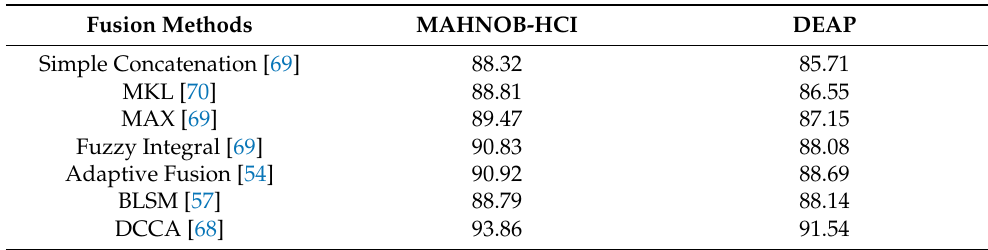
Table 9. Comparison of average accuracies (%) of different fusion methods with DCCA using MAHNOB-HCI and DEAP datasets. Fusion